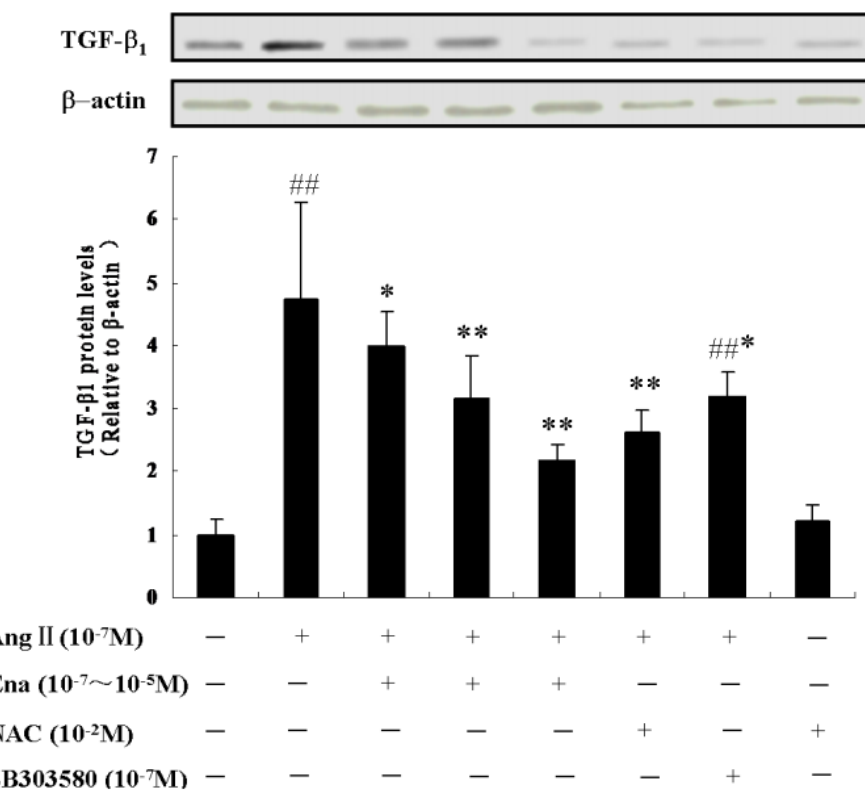
Figure 5. Effect of Ena., NAC and SB203580 on TGF- β Western Blot, Ang II (10 − 7 M), Ena. (10 − 7 M, 10 − 6 M, 10 − 5 M), NAC (10 − 2 M, 30